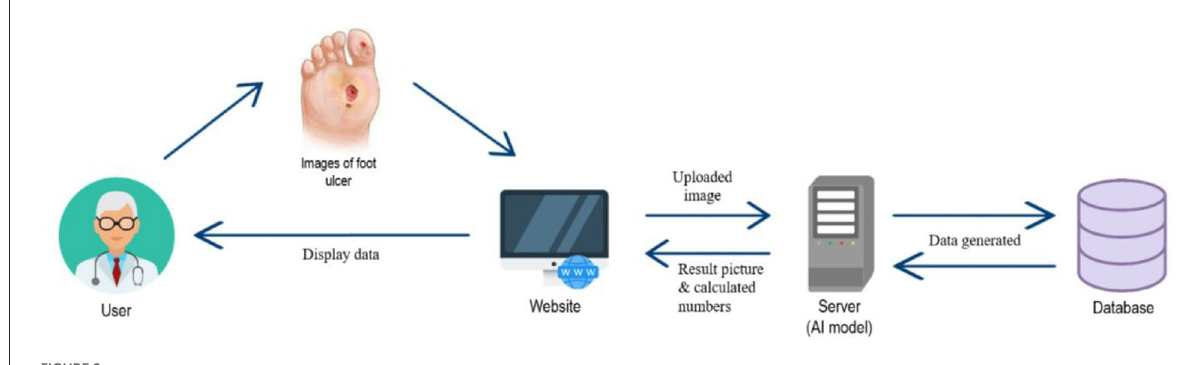
FIGURE2 Data flow